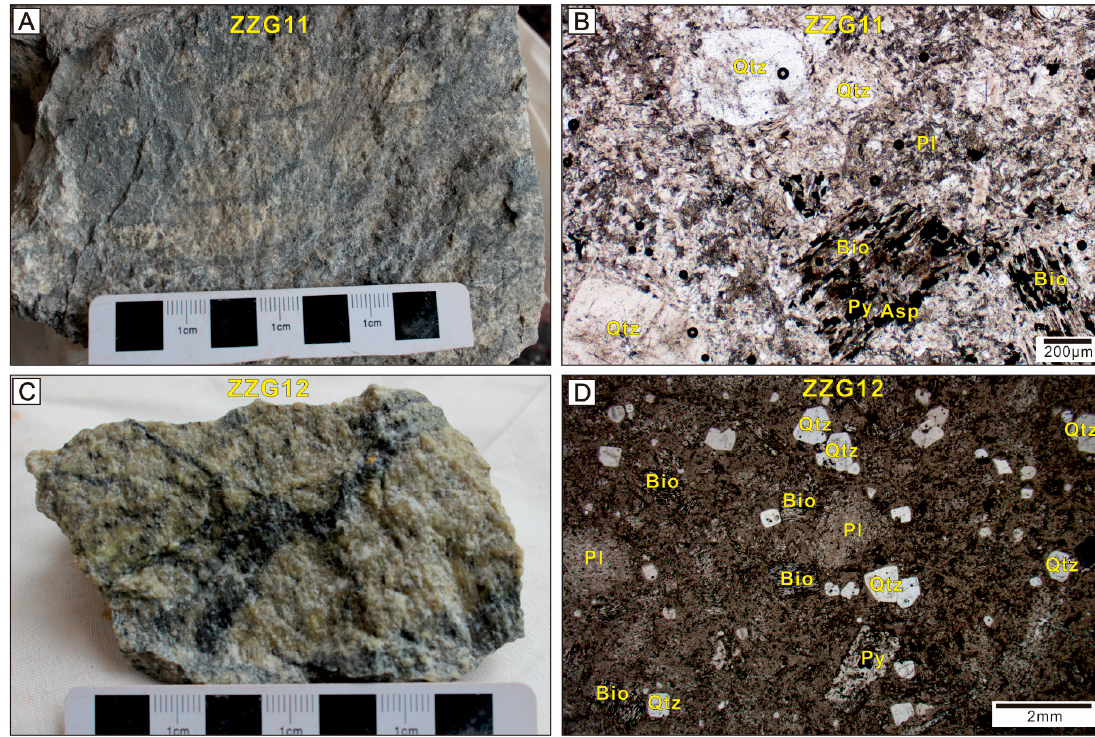
Figure 5. Hand specimen ( A , C ) and photomicrographs under transmitted light ( B , D ) of porphyritic dacite in this study. Py = pyrite, Asp = arsenopyrite, Bio = biotite, Pl = plagioclase, Qtz = quartz, Cal = calcite.